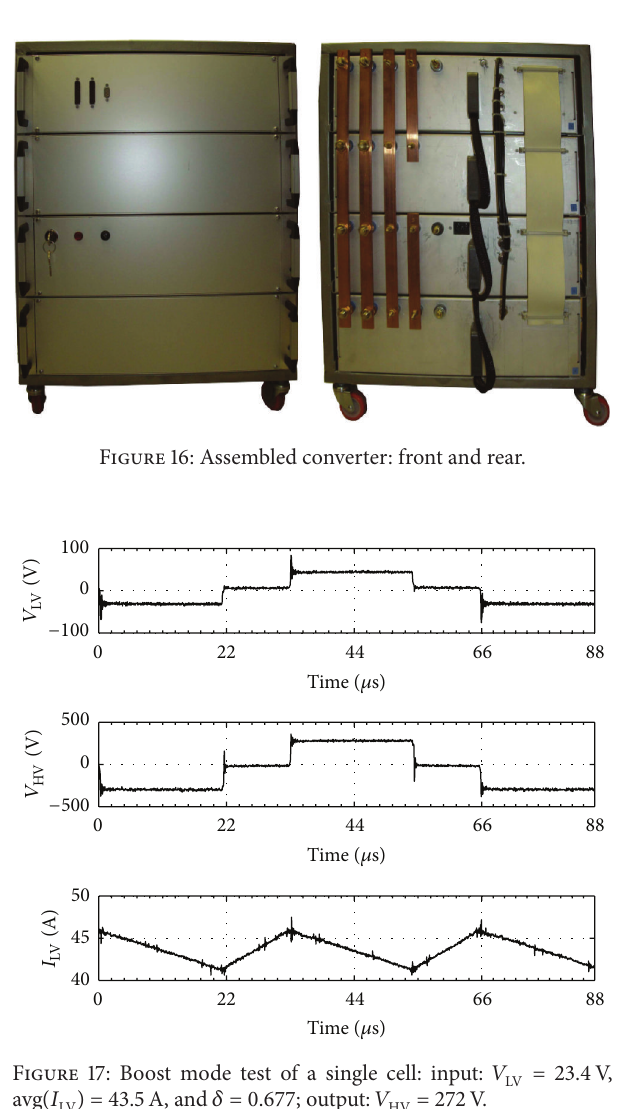
= 23.4 V, LV = 272 V. HV